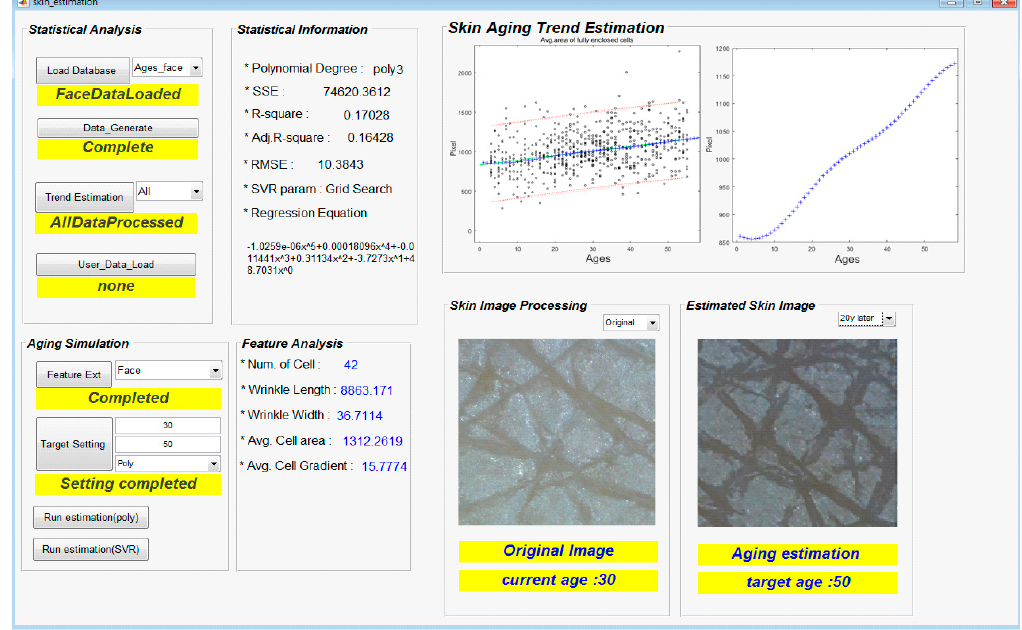
Figure 9. Application interface for skin aging simulation.